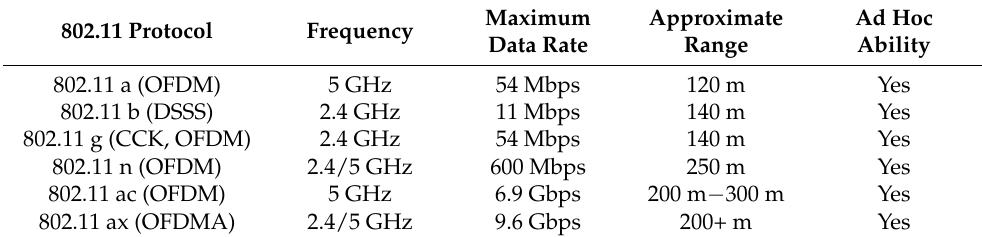
Table 1. Common 802.11 standards